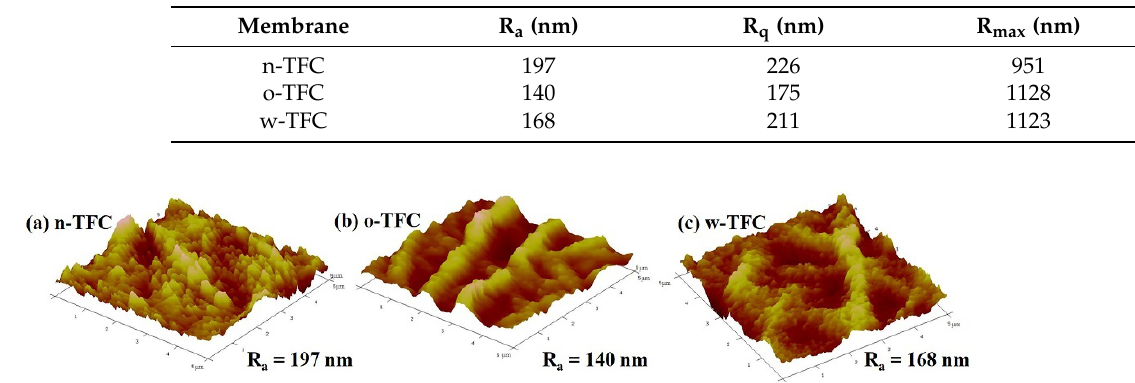
Figure 4. TEM images of the cross-section morphologies of the nanofiber-supported TFC FO membranes prepared via different heat-curing methods: ( a1 , a2 ) n-TFC; ( b1 , b2 ) o-TFC; ( c1 , c2 ) w-TFC.